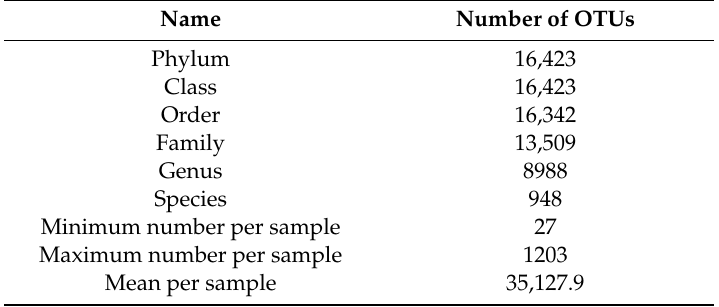
Table 7. Operational taxonomic units classification and classification status identification results.